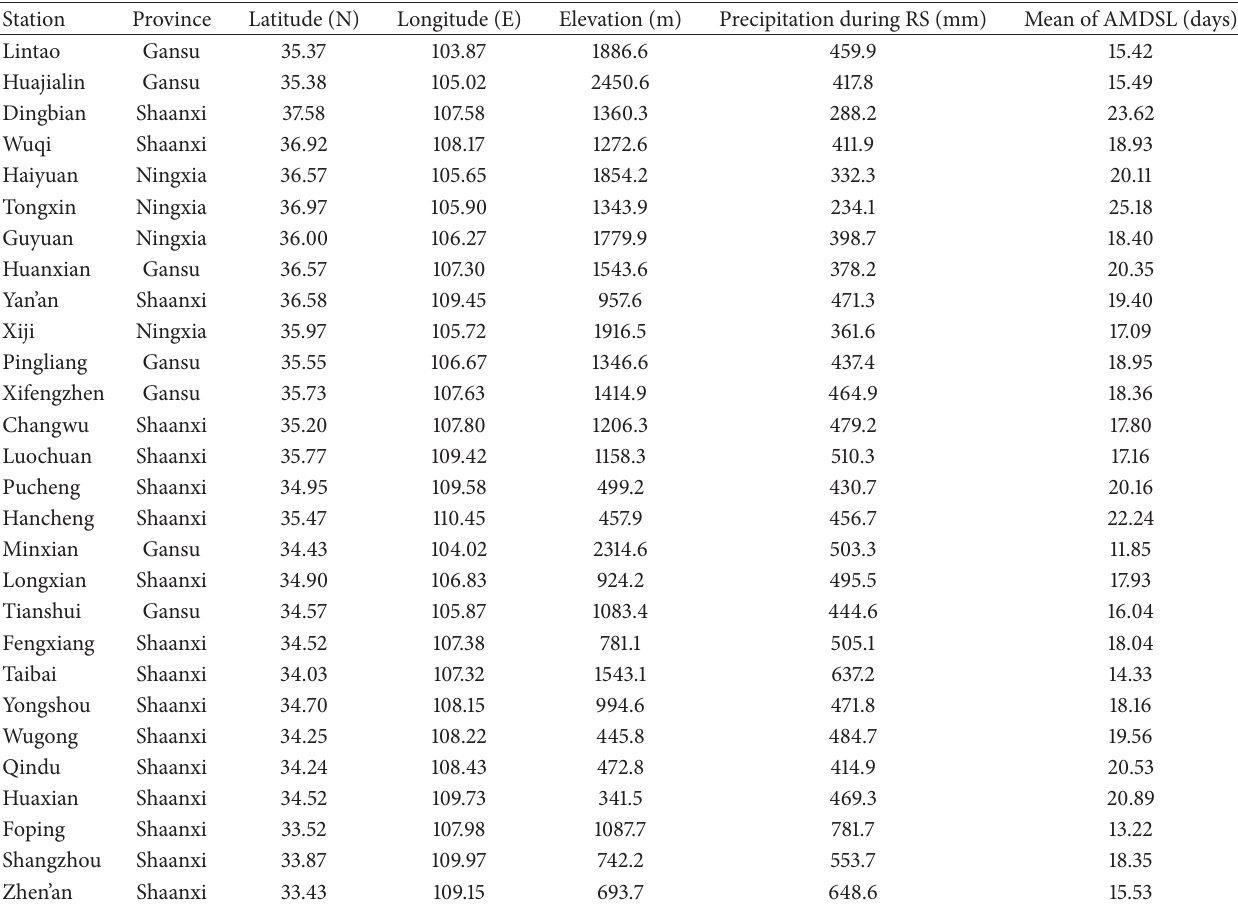
Table 1: The detailed descriptions of meteorological stations in the